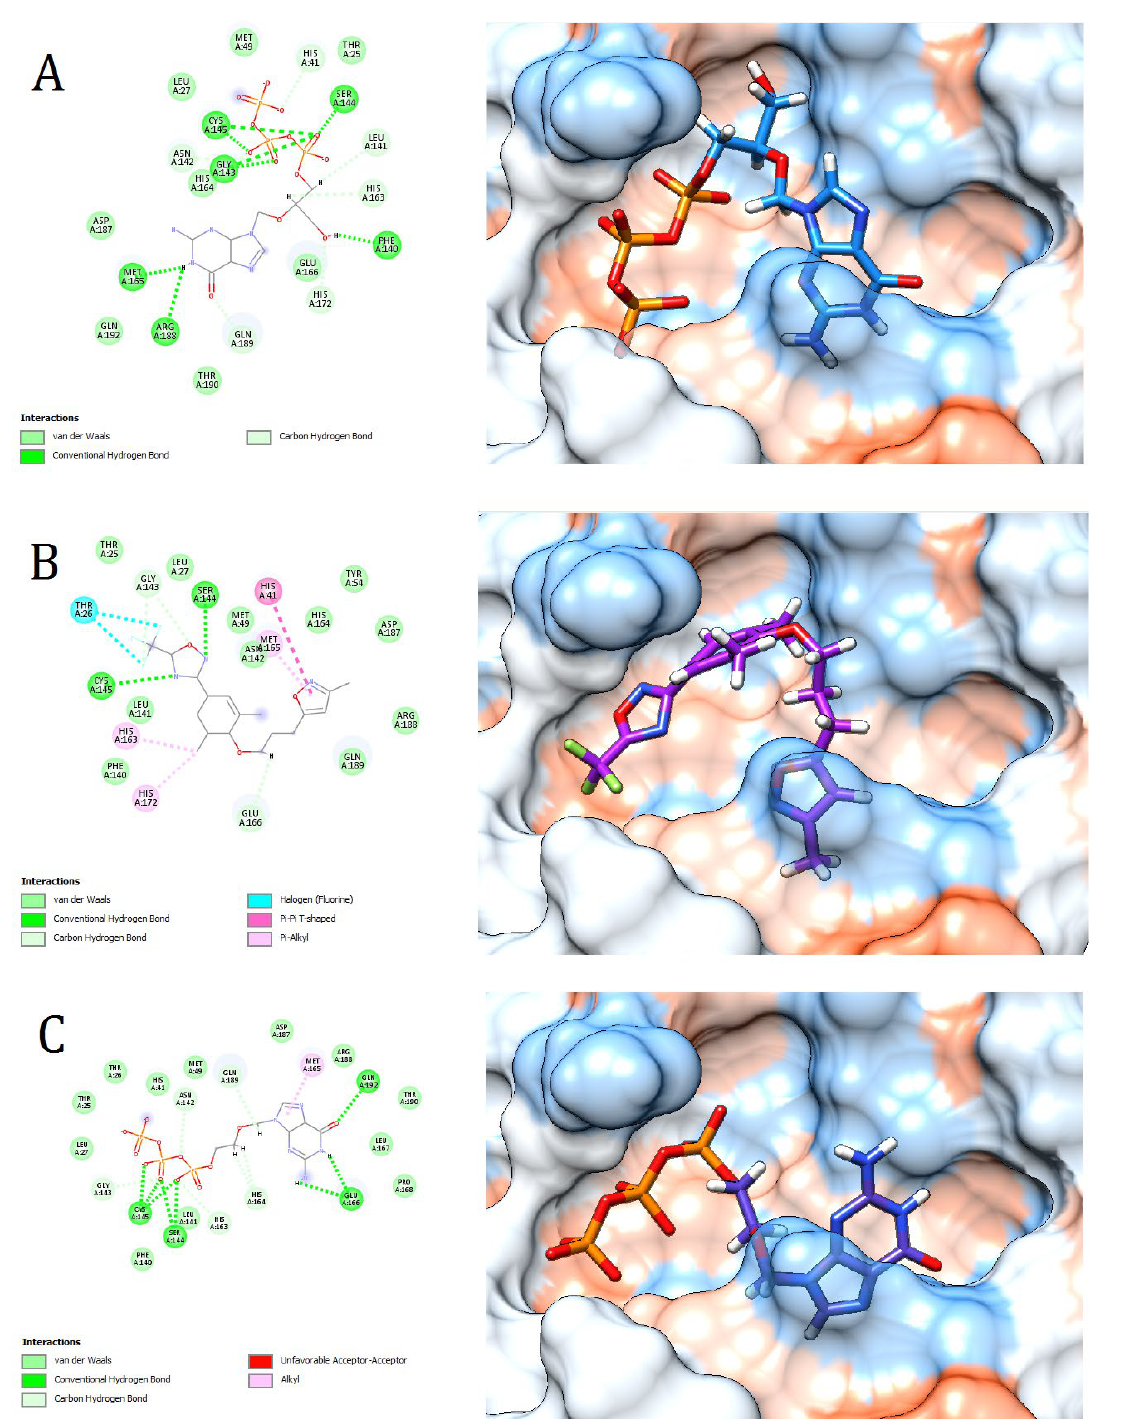
Figure 4. Docking pose visualization for the drugs with the best predicted results (Right) and their 2D receptor-ligand interaction diagram